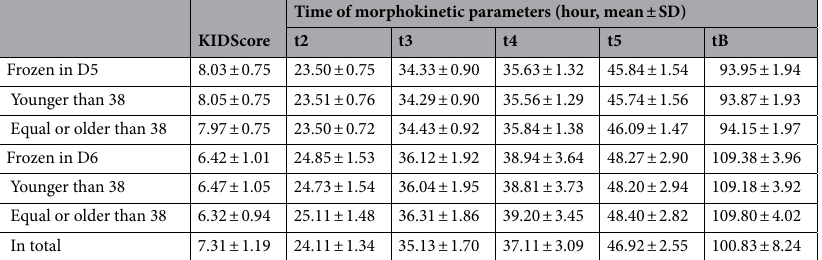
Table 3. Morphokinetic characteristics of blastocysts in this study.